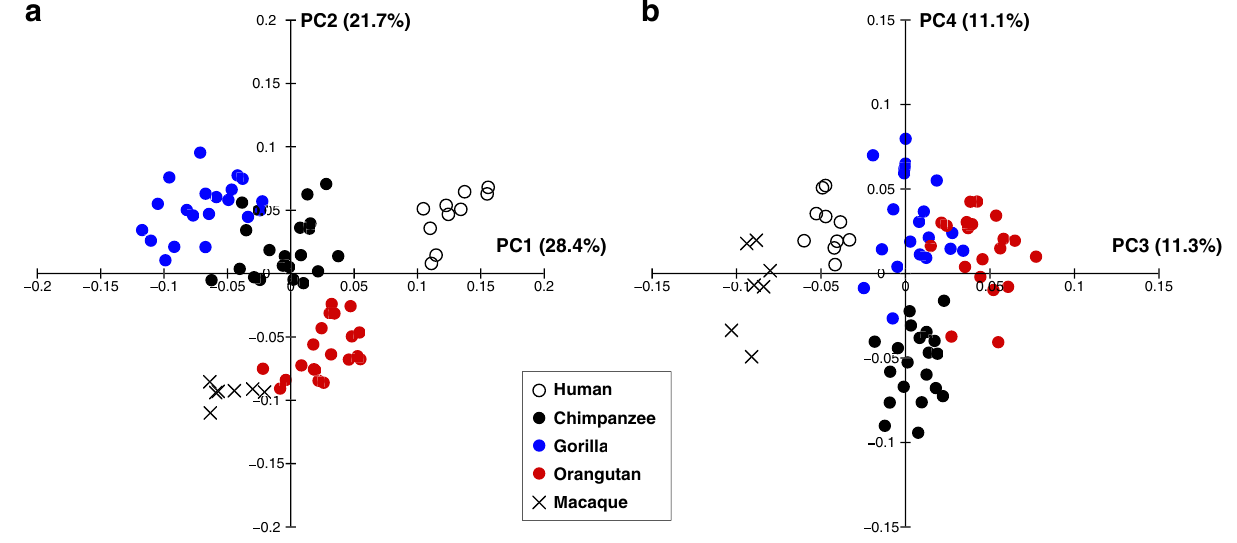
Figure 2. The results of the whole-sample analysis represented as scatter plots of the principal component PC1 versus PC2 ( a ) and PC3 versus PC4 ( b ). The percentage of variance explained by each PC score is shown in parentheses.